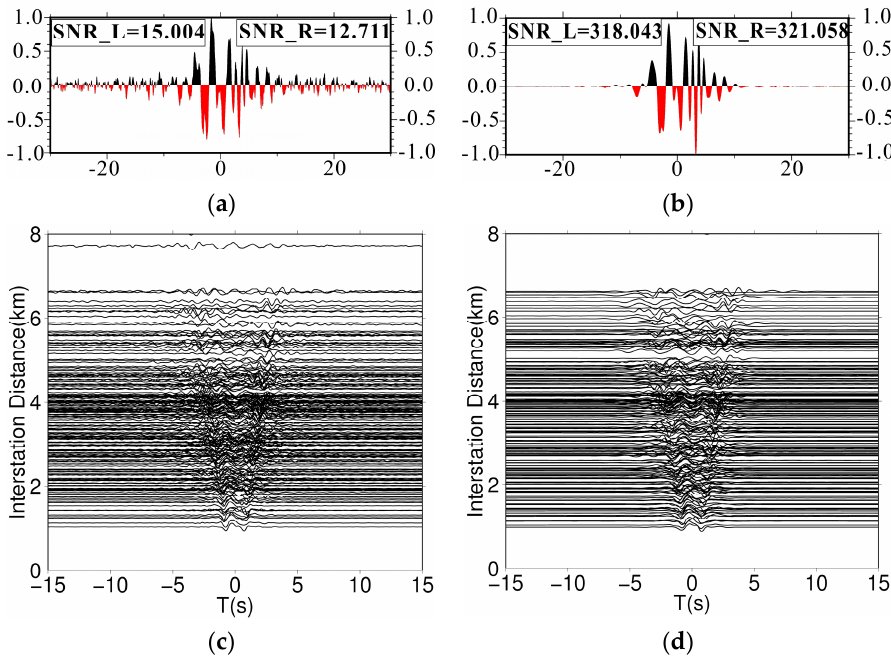
Figure 4. NCFs for one station pair in ( a , b ). ( a ) Linear stack. The SNRs are 15.005 in the acausal part and 12.711 in the causal part. ( b ) tf-PWS. The SNRs are 318.043 and 321.058 in the acausal and causal segments, respectively. The signal-to-noise ratios of acausal and causal parts are increased by 21.2 and 25.3 times, respectively. ( c , d ) are NCFs with both sides of SNRs greater than 20 from two stacking methods: ( c ) linear stack (117 NCFs) and ( d ) tf-PWS (181 NCFs). We only exhibit the period band between 0.35–2 s to visualize extracted Rayleigh waves.